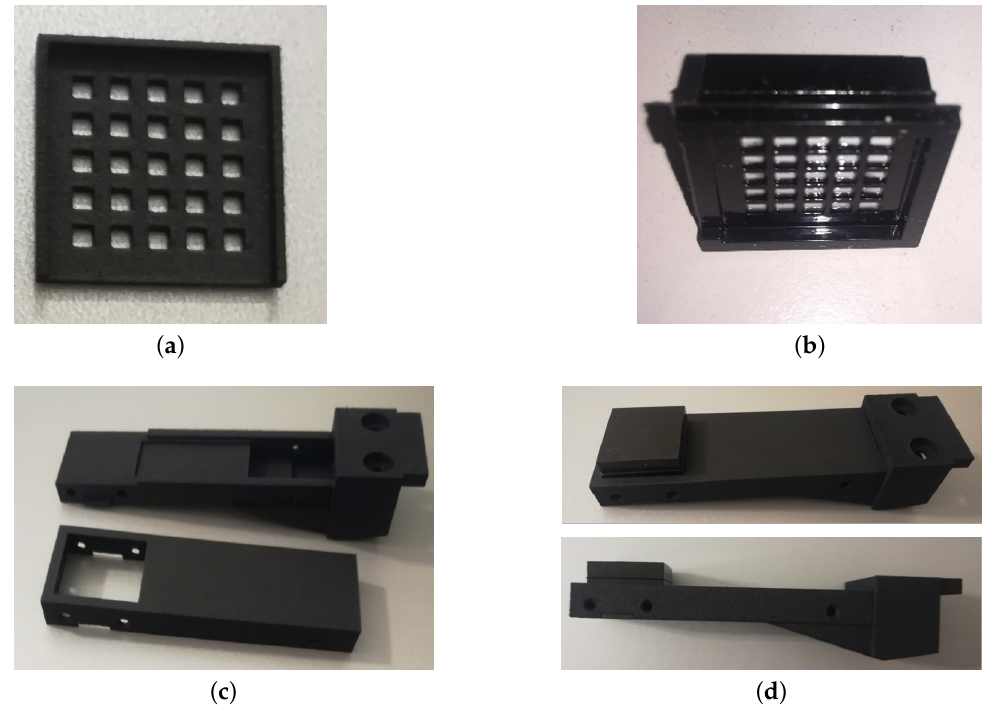
Figure 5. Manufactured grid in black ABS ( a ), deformable layer in silicone ( b ), case in nylon ( c ) and complete assembled finger ( d